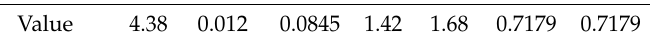
Table 2. Comparison of tested and calculated data on the spillway flood discharge ( α = 45°, q w = 251 m 2 /s).